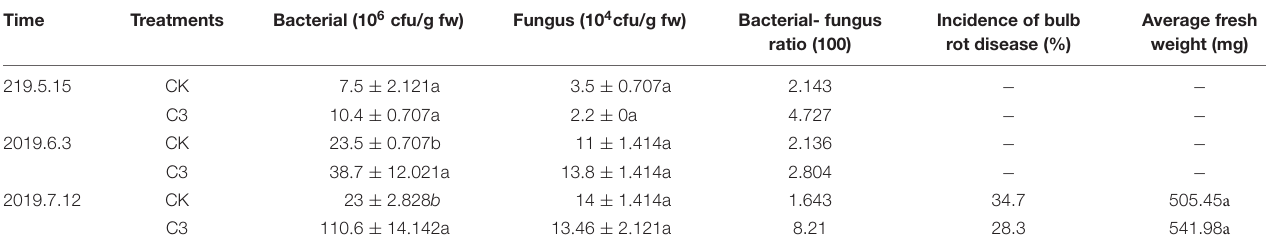
TABLE 4 | Effect of C3 on Soil Microorganisms of F. Taipaiensis